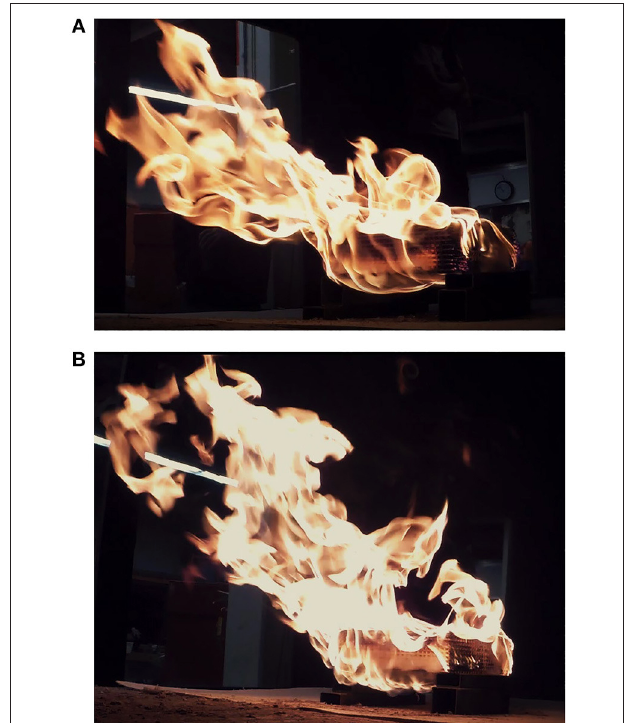
FIGURE 10 | Crib design #22 in 0.7 m/s (A) and 0.24 m/s (B) wind from behind demonstrating flames hugging the top and bottom sides of the fuel bed, blocking airflow from